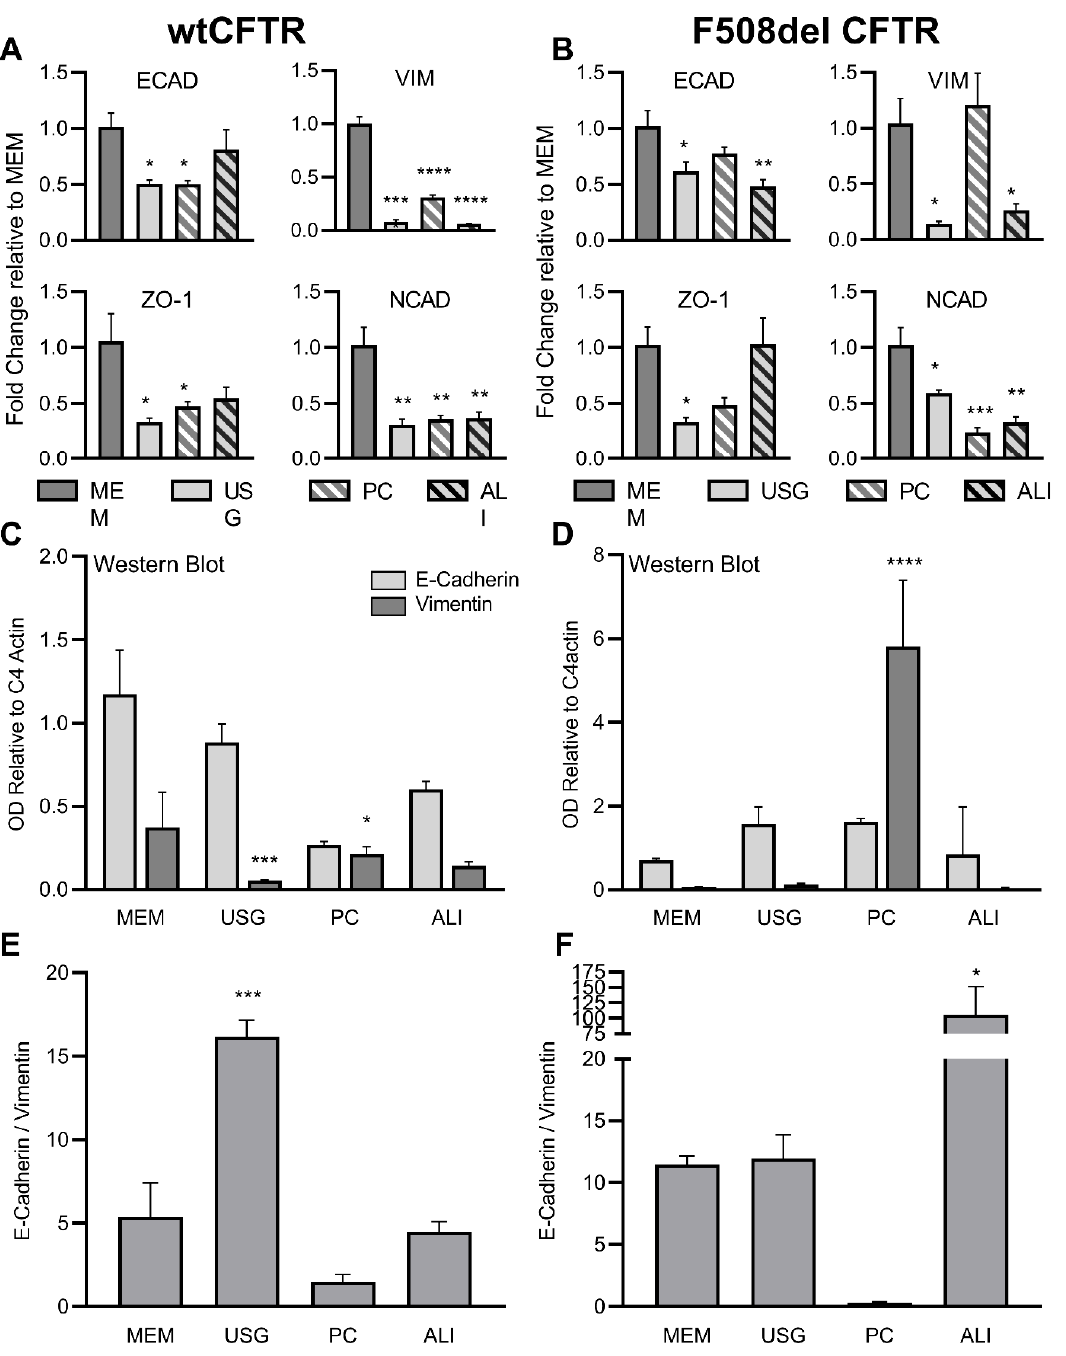
Figure 1. Media selection impacts epithelial and mesenchymal marker expression in wtCFTR and F508del CFBE41o- cells. RT qPCR was performed for e-cadherin, vimentin, zo-1, and n-cadherin in wtCFTR- ( A ) and F508del ( B )-expressing CFBE41o- cells following growth in different media. Expression was normalized to actin and expressed as fold change relative to MEM media. Sim- ilar relative trends were noted for immunoblot of e-cadherin and vimentin in wtCFTR- ( C ) and F508del ( D )-expressing cells. Statistical comparisons were made within the protein of interest (e.g., vimentin:vimentin), comparing each media to MEM. OD was normalized to C4 Actin. Light grey—E-Cadherin; dark grey—vimentin. Using these immunoblot data, an e-cadherin to vimentin ra- tio was calculated for wtCFTR- ( E ) and F508del ( F )-expressing cells. * p < 0.05; ** p < 0.01; *** p < 0.001; **** p < 0.0001 vs. MEM by one-way ANOVA with Dunnett’s multiple comparison